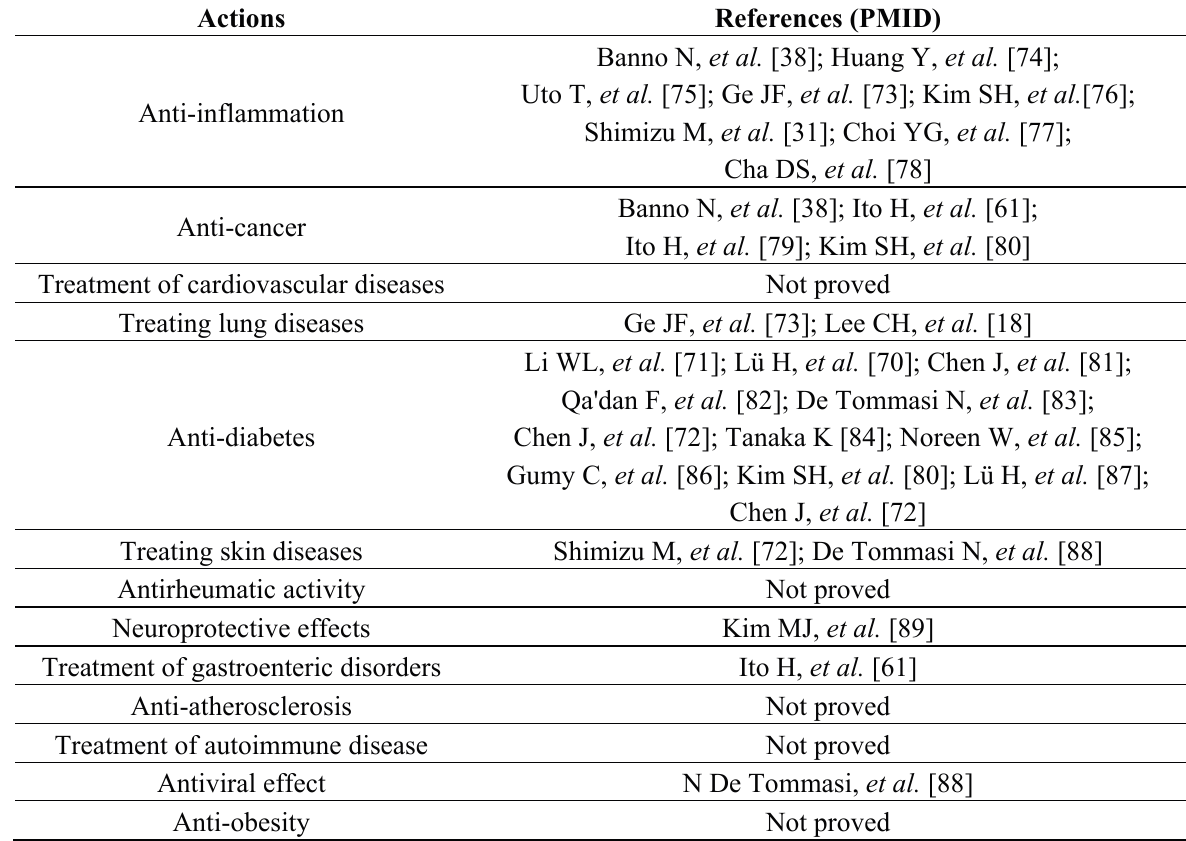
Table 3. The pharmacological actions of Folium